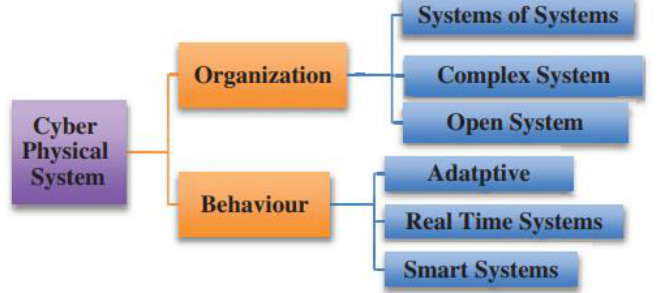
Figure 8. Configuration of a CPS [82].